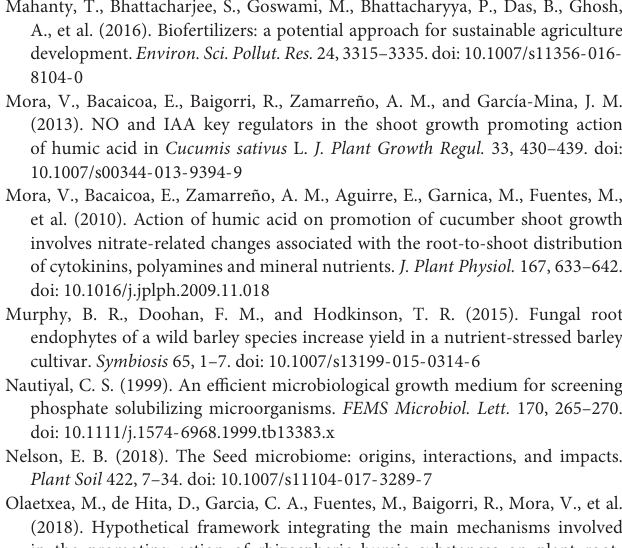
(2018). Hypothetical framework integrating the main mechanisms involved in the promoting action of rhizospheric humic substances on plant root-